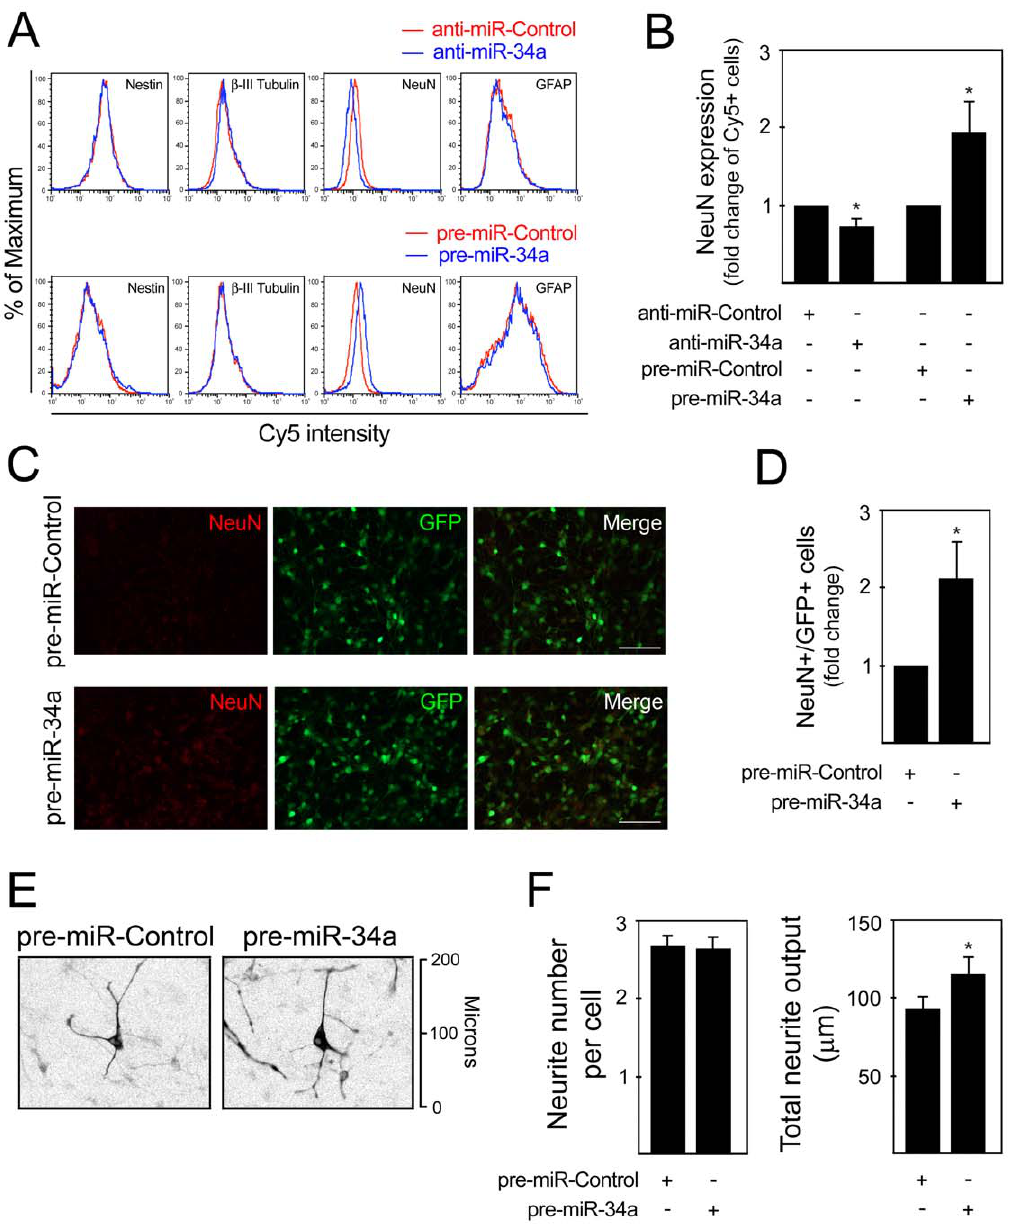
Figure 1. miR-34a modulates the proportion of NeuN-positive cells and neurite outgrowth. Mouse NS cells were transfected using 100 nM of either anti- or pre-miR-34a at 3 days, and collected after 24 and 72 h, respectively. Cells were subsequently labeled for Nestin, b -III Tubulin, NeuN and GFAP detection by flow cytometry. A. Representative histograms of Nestin, b -III Tubulin, NeuN and GFAP detection in anti-miR-control (red line) and anti-miR-34a-transfected cultures (blue line) ( top ), or in pre-miR-control (red line) and pre-miR-34a-transfected cultures (blue line) ( bottom ). In four independent experiments, similar alterations in the relative number of positive cells for each marker were observed. B. Quantification data of NeuN-positive cells assessed by flow cytometry after miR-34a modulation. C. Immunofluorescence detection of NeuN expression in 6 day cells transfected with pre-miR-Control and pre-miR-34a for 72 h. Scale bar, 50 m m. D. Quantification data of NeuN-positive cells assessed by immunocytochemistry after miR-34a modulation. E. Representative images of b -III Tubulin + cells 48 h after pre-miR-transfection. Fluorescent images are shown in black and white and inverted for clarity. F. Neurite number and total neurite output are given to quantify the effect of miR-34a overexpression on cellular morphology. Neurites were manually traced using ImageJ v 1.43 and the NeuronJ plugin v 1.4.2. Results are shown as mean 6 SEM. * p , 0.05 from cells transfected with respective control.